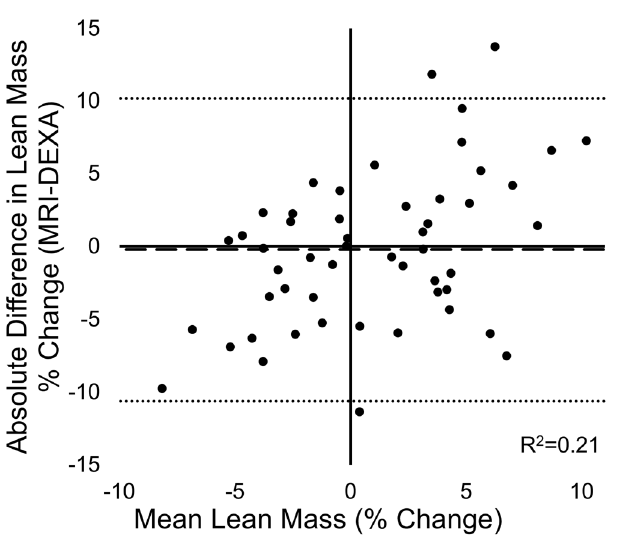
Figure 2. Correlation between MRI and DXA measures of percent change. There was only a modest positive association between the percentage change in estimates of muscle size between the MRI and DXA techniques, such that explained variance was only 24% ( r = 0.49 p < 0.01).